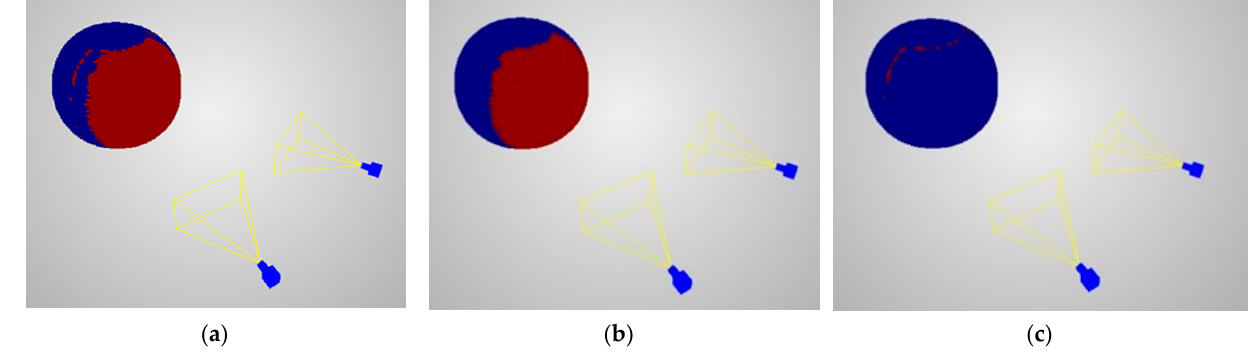
Figure 8. Reconstruction coverage on two camera scenarios with the sphere on the Z -axis at 2-m distances: ( a ) evaluations, ( b ) predictions, ( c ) differences. Red points represent areas where the sphere was reconstructed for evaluations and predictions and for differences where the evaluations differed from predictions. Blue points show otherwise.